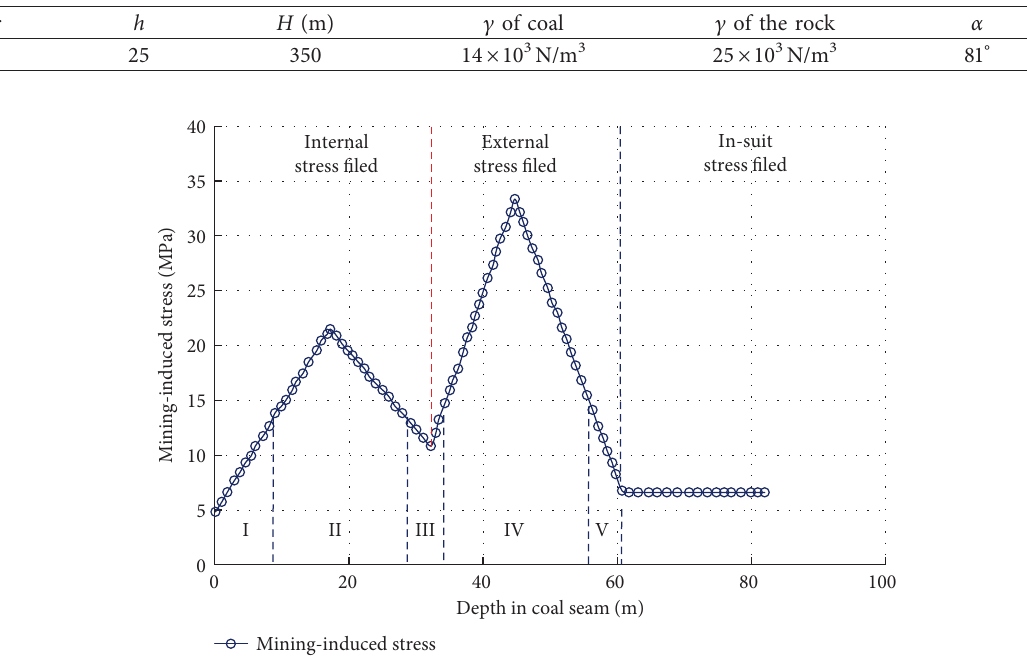
Figure 4: The distribution of mining-induced stress in the coal seam.